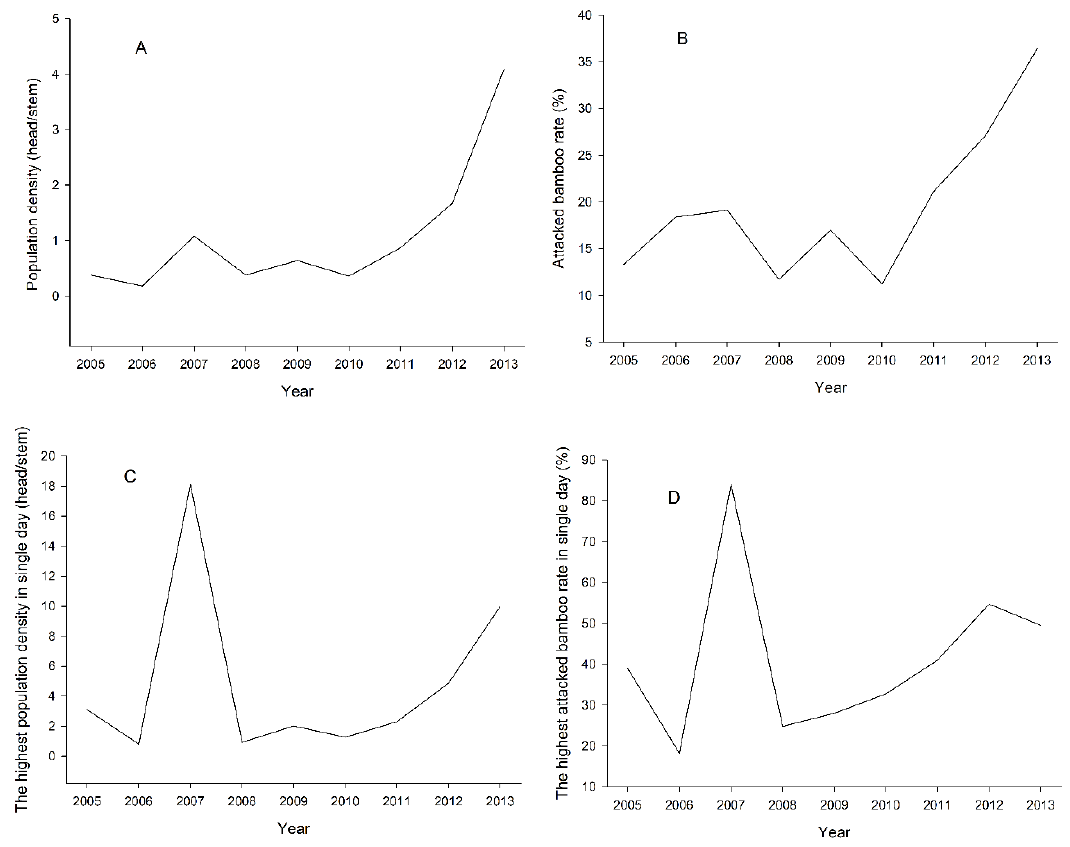
Figure 2. The population density ( A ), attacked bamboo rate ( B ), highest population density in single day ( C ), and highest attacked bamboo rate in single day ( D ) April from 2005 to 2013. The number of moso bamboo plants surveyed each year is 4400, and the survey site is located at Anji County, Huzhou City, Zhejiang Province, China.